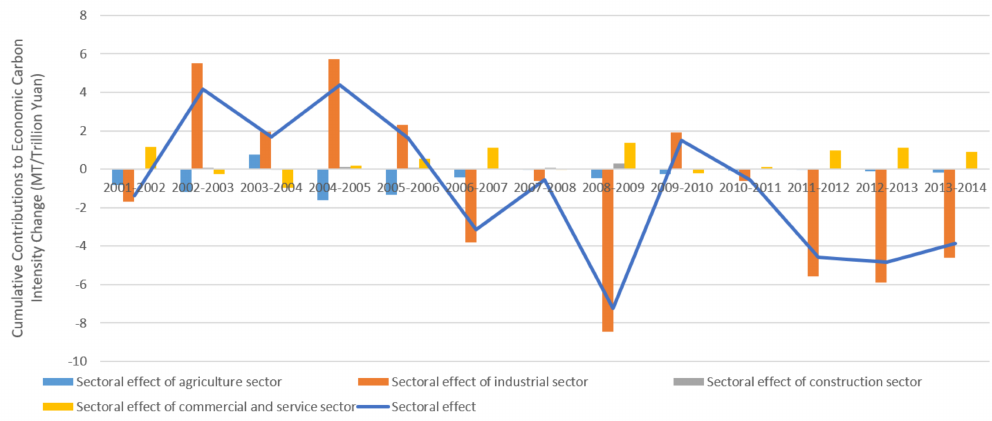
Figure 4. Annual Contributions of the Sectoral Structure Change to the Economic Carbon Intensity